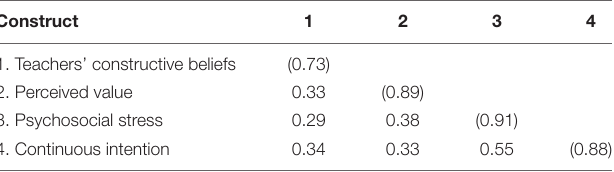
TABLE 3 | Discriminant construct